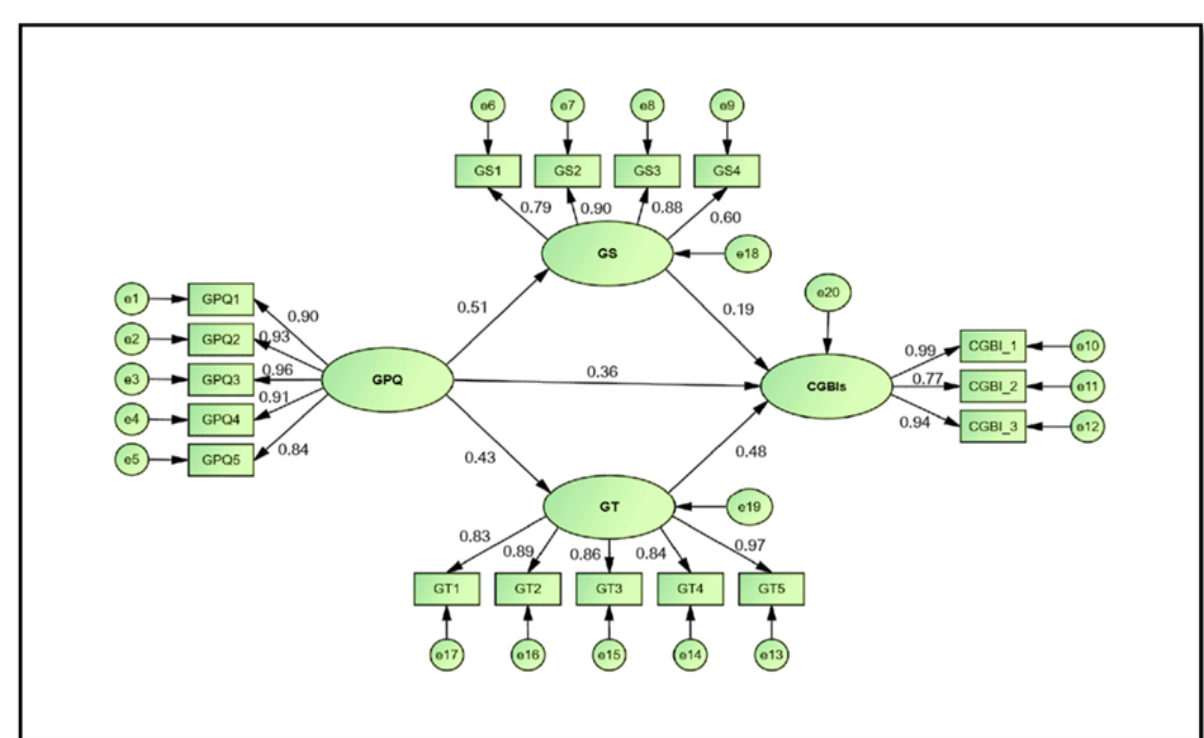
Figure 2. The structural model.